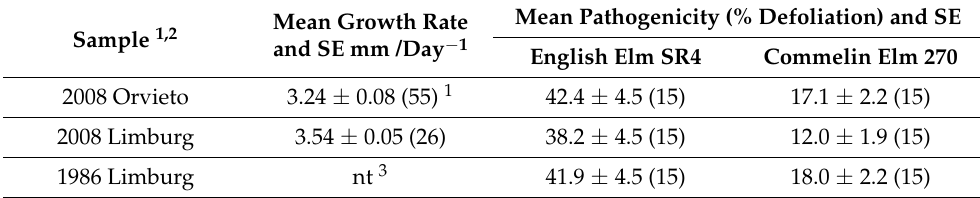
Table 2. Comparative growth rate and pathogenicity of Limburg and Orvieto samples.